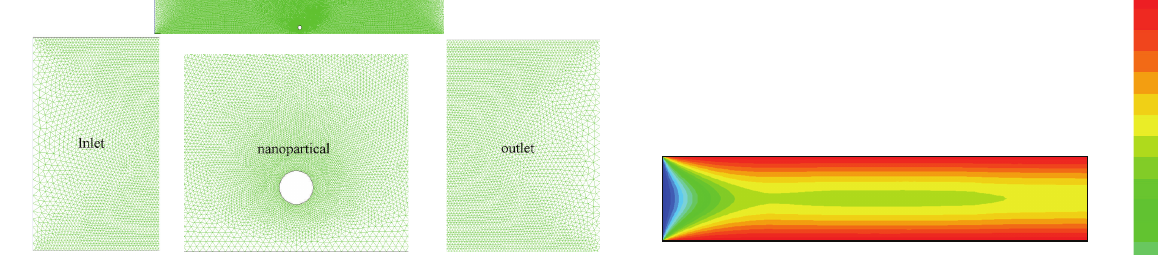
Figure 3: Mesh model of base case.